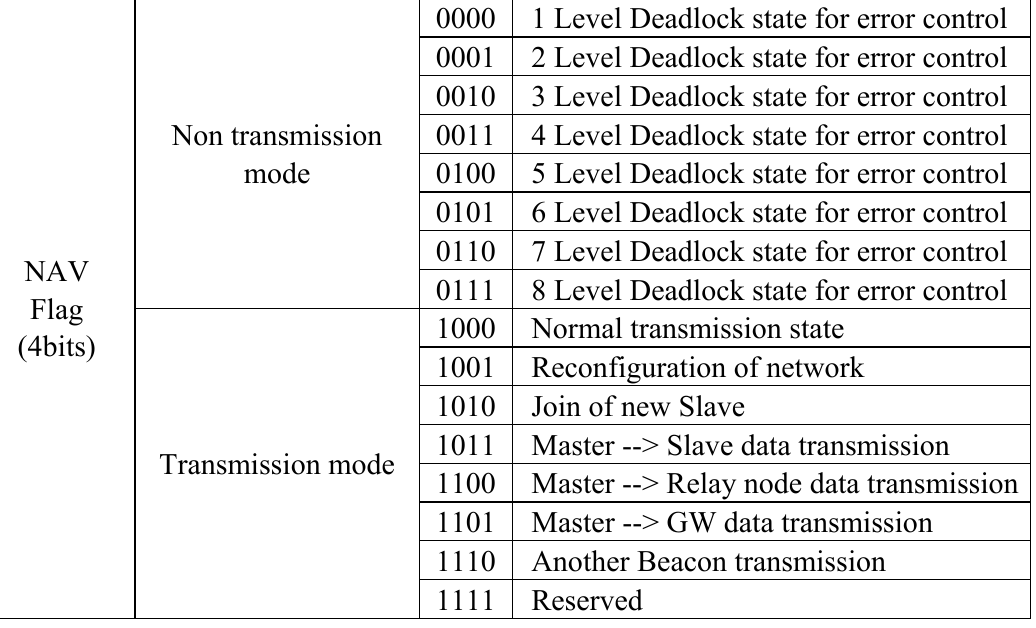
Table 7. Ack type.